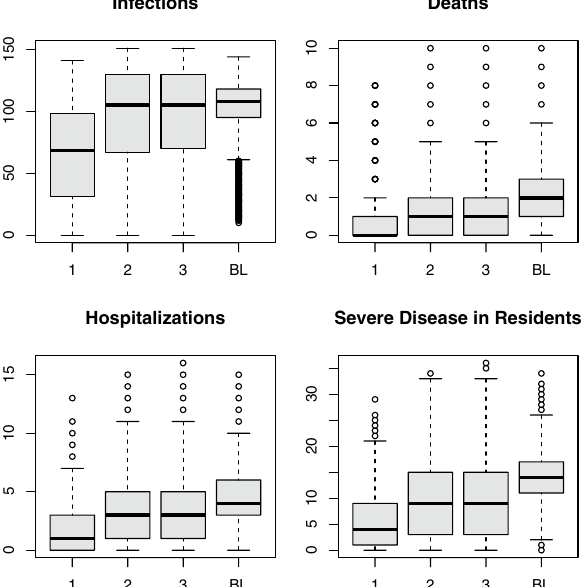
Figure 1. Disease outcomes by scenario. Comparison of total infections, severe infections in residents, hospitalizations, and deaths over 100 days in simulated populations of 100 residents and 51 healthcare workers at long-term care facilities. Scenarios 1, 2, and 3 paired vaccination with strong, gradually reduced, and weak adherence to NPIs, respectively. Scenario BL (baseline) included no vaccination but strong adherence to NPIs. Reduction in infection and disease burden was weaker under relaxing or weak NPI adherence when compared to the strong NPI adherence scenario. Boxplots show median, 1st and 3rd quartile, and whiskers extend to 1.5 times the interquartile range. Statistical outliers included as open